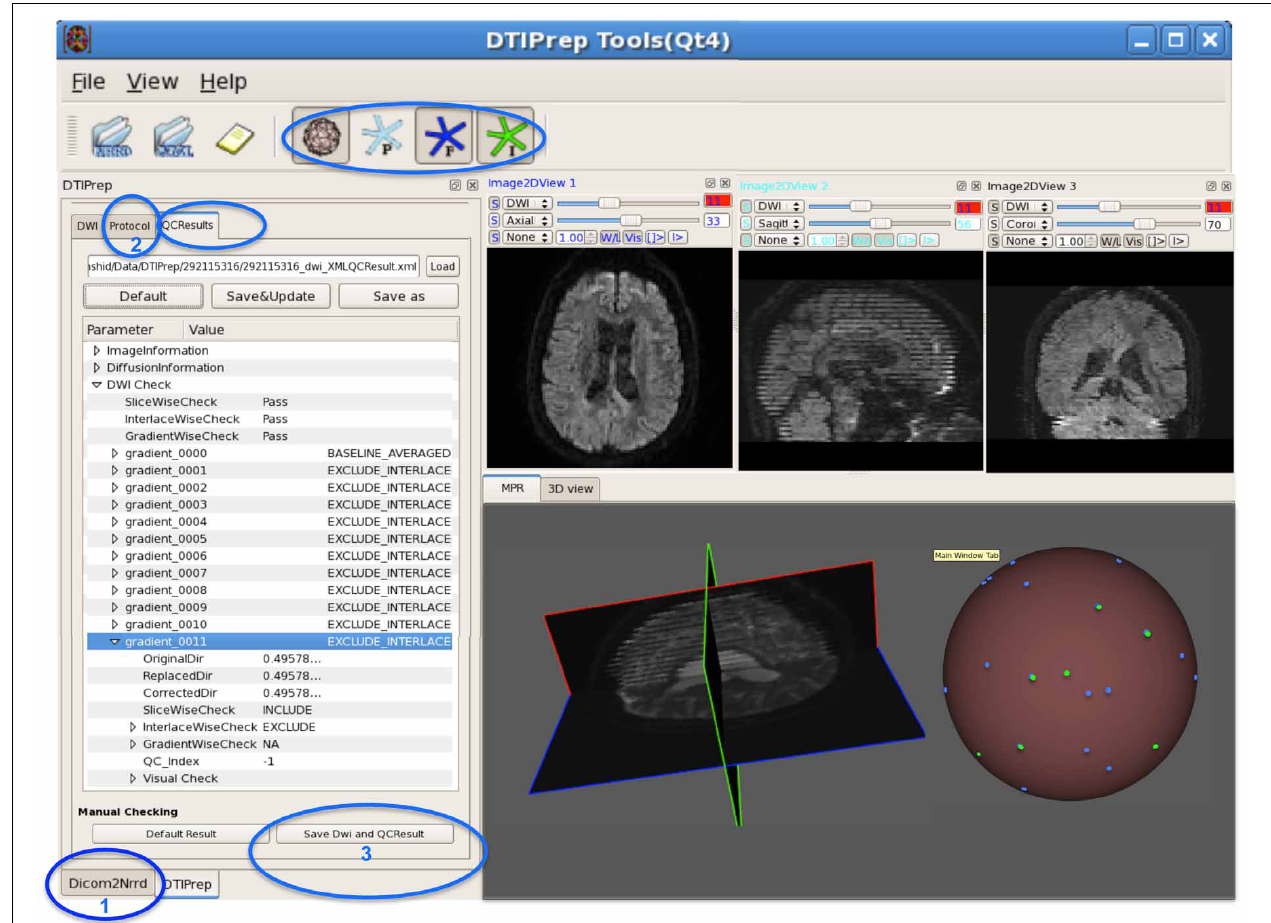
FIGURE 4 | DWI-based QC results using DTIPrep through three steps. (1) converting the DWI image from DICOM to NRRD format, (2) loading the protocol and running the software, and (3) if necessary, visual checking and saving the final DWI dataset. In this example, gradient #11 suffers from intensity artifact and is excluded. The sphere shows a 3D view of the